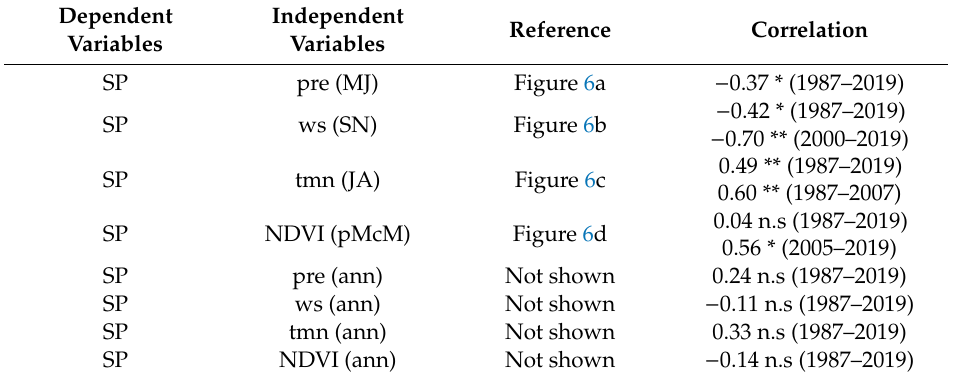
Table 2. Correlation analysis for sheep production and climatic variables. Significance is indicated by. * 95%, ** 99%, or n.s = not